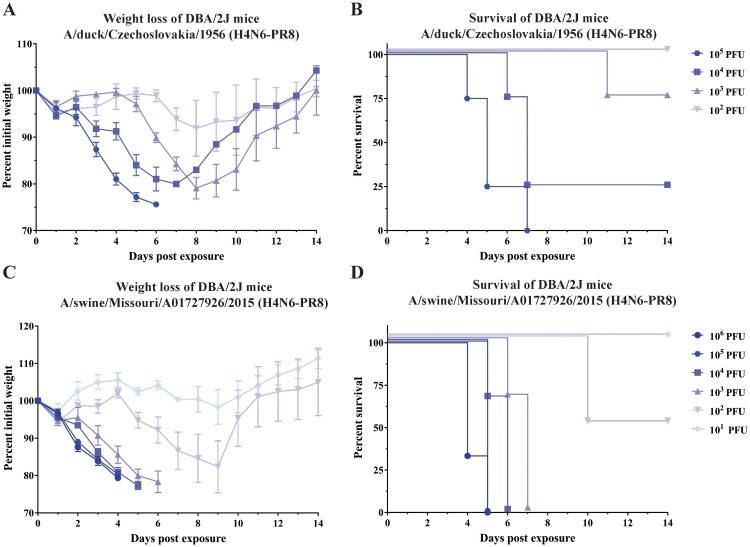
Infection of DBA/2J mice with recombinant H4N6 viruses in the PR8 background. (A) Weight loss of mice (n = 4) after infection with A/duck/Czechoslovakia/1956 (H4N6-PR8). DBA/2J mice were infected with various doses of A/duck/Czechoslovakia/1956 (H4N6-PR8) and monitored for 14 days after infection. (B) Survival of mice after infection with A/duck/Czechoslovakia/1956 (H4N6-PR8). DBA/2J mice were infected with various doses of A/duck/Czechoslovakia/1956 (H4N6-PR8) and weight loss was monitored for 14 days after infection. (C) Weight loss of mice after infection with A/swine/Missouri/A01727926/2015 (H4N6-PR8). DBA/2J mice were infected with various doses of A/swine/Missouri/A01727926/2015 (H4N6-PR8) and monitored for 14 days after infection. (D) Survival of mice after infection with A/swine/Missouri/A01727926/2015 (H4N6-PR8). DBA/2J mice were infected with various doses of A/swine/Missouri/A01727926/2015 (H4N6-PR8) and weight loss was monitored for 14 days after infection.